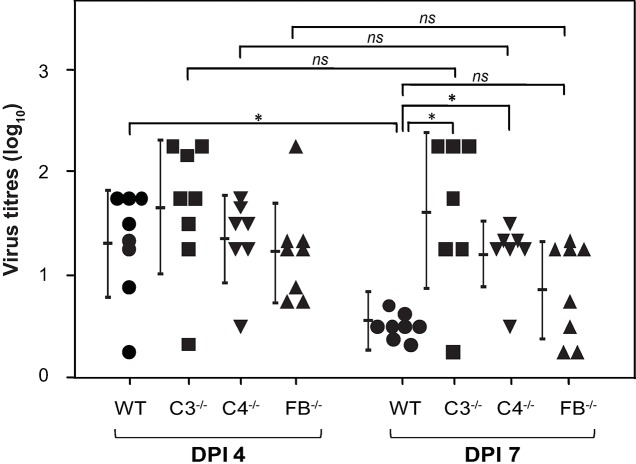
Complement deficient mice infected with A(H1N1)pdm09 virus show prolonged infection.WT (C57BL/6) and complement deficient mice (C3-/-, C4-/- and FB-/- mice on C57BL/6 background) were infected intranasally with the pandemic influenza virus (450 TCID50), euthanized at day 4 or 7 post-infection, and lungs were harvested for estimation of the virus load. Virus titer was determined in the lung homogenates by TCID50 analysis. C3-/- and C4-/- mice retained significantly higher virus load at day 7 post-infection compared to the WT mice. Bars represent mean ± SD. *p < 0.05 (Mann–Whitney Rank Sum test, IBM PASW). ns indicates not significant.